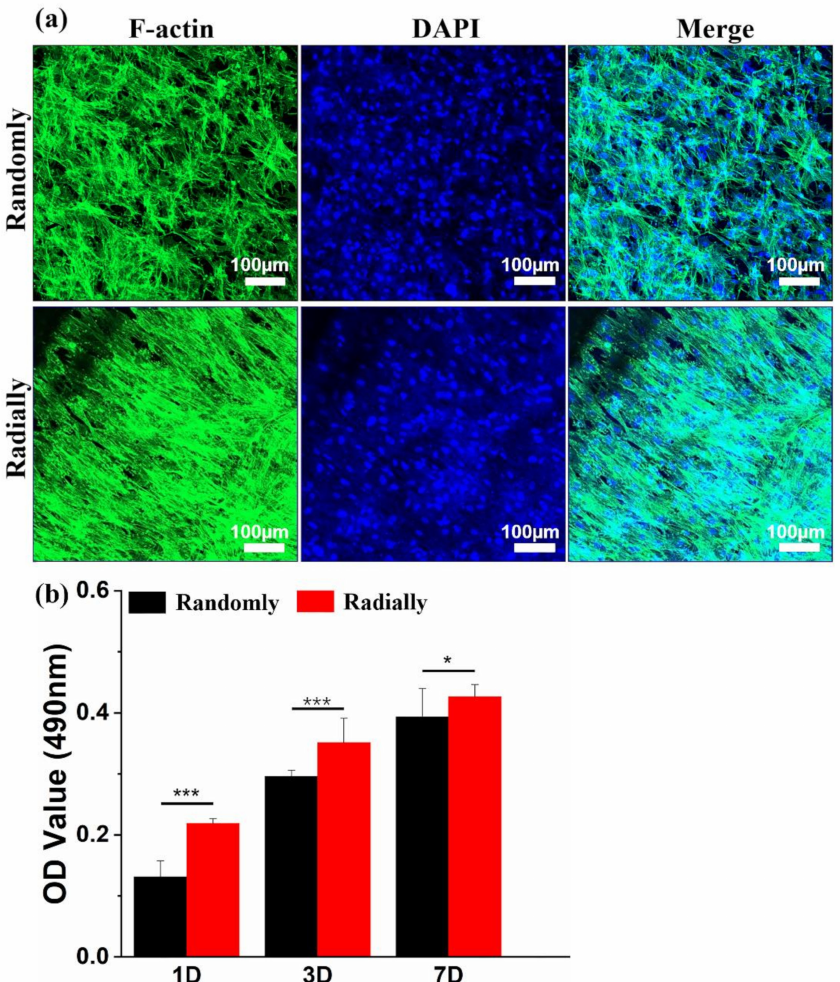
Figure 8. ( a ) Fluorescent images of F-actin (green) and nuclei (blue) staining on day 7 after HAMSCs were seeded and cultured on PHBV nanofiber scaffolds with both randomly and radially oriented patterns. ( b ) MTT results after HAMSCs were seeded and cultured on two different samples over 7 days (n = 5; * p < 0.05, *** p <